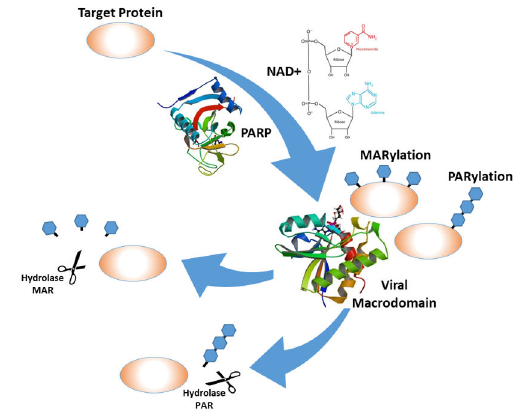
Figure 1. A schematic representation of the ADP-ribosylation and de-ADP-ribosylation by the viral macrodomains: The crystal structures of the poly-ADP-ribose polymerase (PARP)-12 protein [10] were downloaded from the protein data bank (PDB) (doi:10.2210 / pdb2PQF / pdb), and the Venezuelan equine encephalitis virus (VEEV) macrodomain structure [11] was downloaded from the PDB (doi:10.2210 / pdb5mqx /